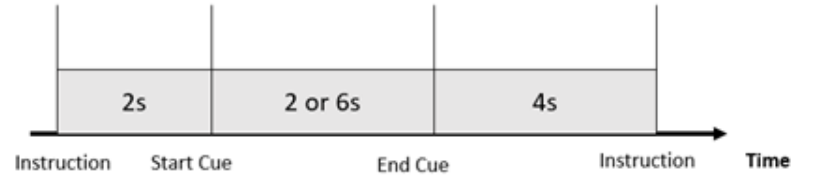
Figure 3. Timing of the training session.